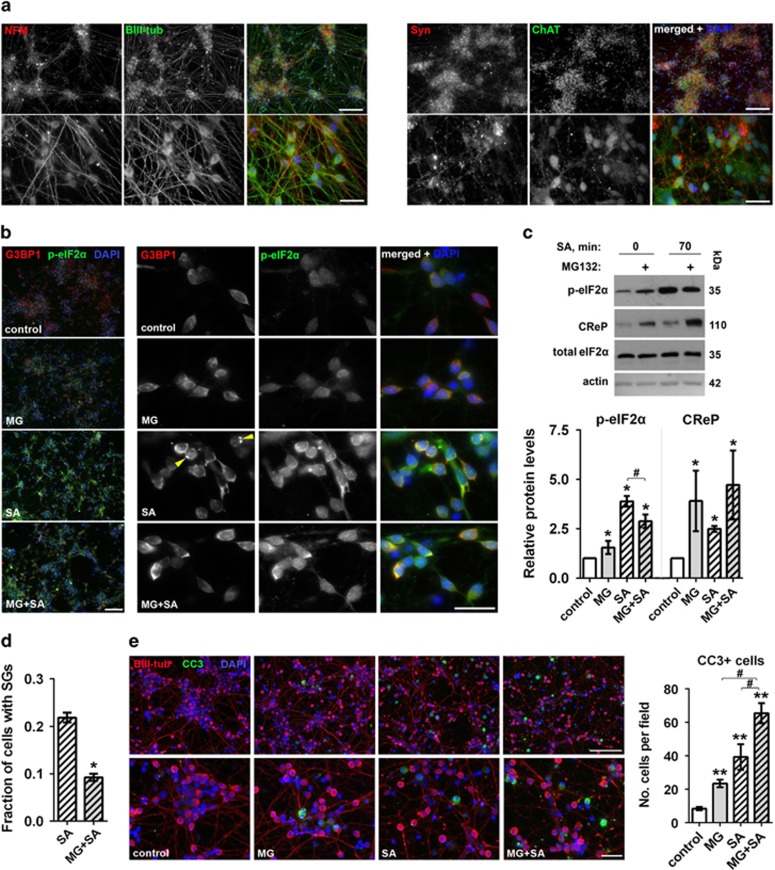
Stress preconditioning of human ES-derived neurons impairs their ability to maintain p-eIF2α levels and SG assembly. (a) Characterization of differentiated human neurons used in the study. Day 40 cultures of neurons differentiated from hES cells express typical neuronal markers βIII-tubulin, synaptophysin and neurofilament M, as well as a motor neuron marker ChAT. (b) G3BP1-positive SGs and increased level of p-eIF2α in human neurons after 70 min of exposure to SA. Left column shows general plane images of treated and untreated cultures. Representative images are shown. Arrowheads indicate cells with SGs. (c) Pretreatment with MG132 upregulates CReP protein and results in attenuated build-up of p-eIF2α following SA stress as compared with control neurons. Representative western blots and quantification of band intensities are shown (n=4, * and #P<0.05, asterisks indicate significant difference as compared with control cells). (d) Pretreatment with MG132 reduces the fraction of human neurons with SGs following SA stress. Fraction of neurons with G3BP1-positive SGs in was quantified (~400 neurons per condition, *P<0.05). (e) MG132 pretreatment decreases survival of human motor neurons during oxidative stress. MG132-pretreated and control cultures were treated with SA for 70 min and the number of cleaved caspase 3 (CC3)-positive cells was quantified from three independent experiments as described in Materials and methods section (#P<0.05, **P<0.01, asterisks indicate significant difference as compared with control cells). Representative images for all conditions are also shown. Motor neuron cultures were pretreated with 1 μ MG132 for 4 h in all panels. Scale bars, 200 μm for top panels in (a), left column in (b) and top panel in (e); and 10 μm for bottom panel in (a), right columns in (b) and bottom panel in (e)